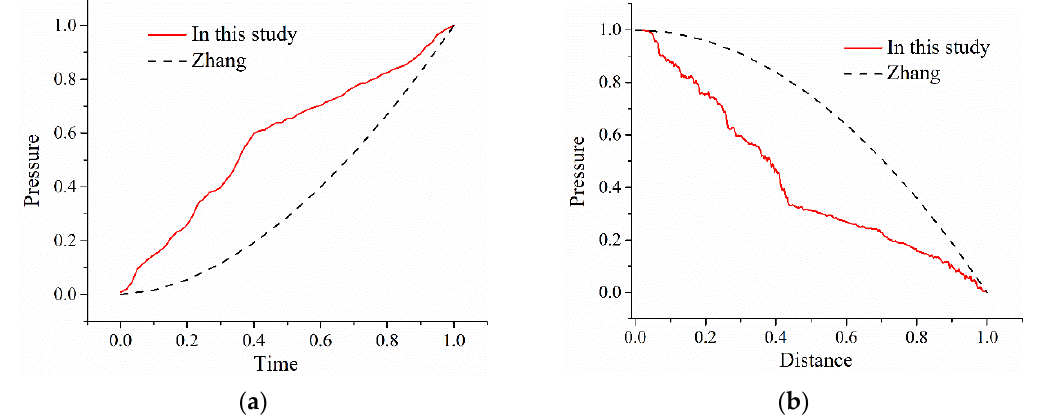
Figure 7. ( a ) is the comparison of the injection pressure at different times between this study and Zhang’s study. ( b ) is the comparison of the pressure distribution along with the diffusion distance between this study and Zhang’s study.